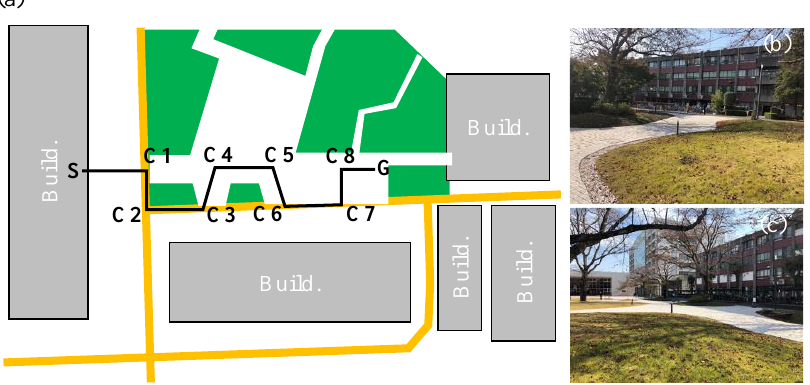
Figure 11. ( a ) Route of the navigation experiment and photographs of the landscape ( b ) from S to C2 and ( c ) from C5 to G. Table 8. Experimental conditions.